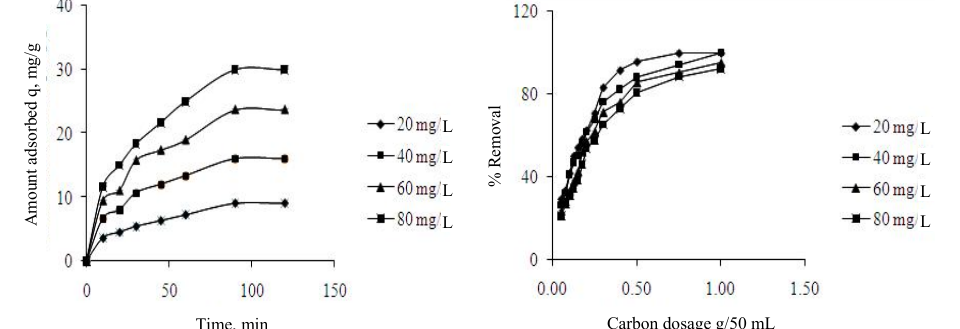
Figure 1. Effect of agitation time on adsorption: Initial concentration variation